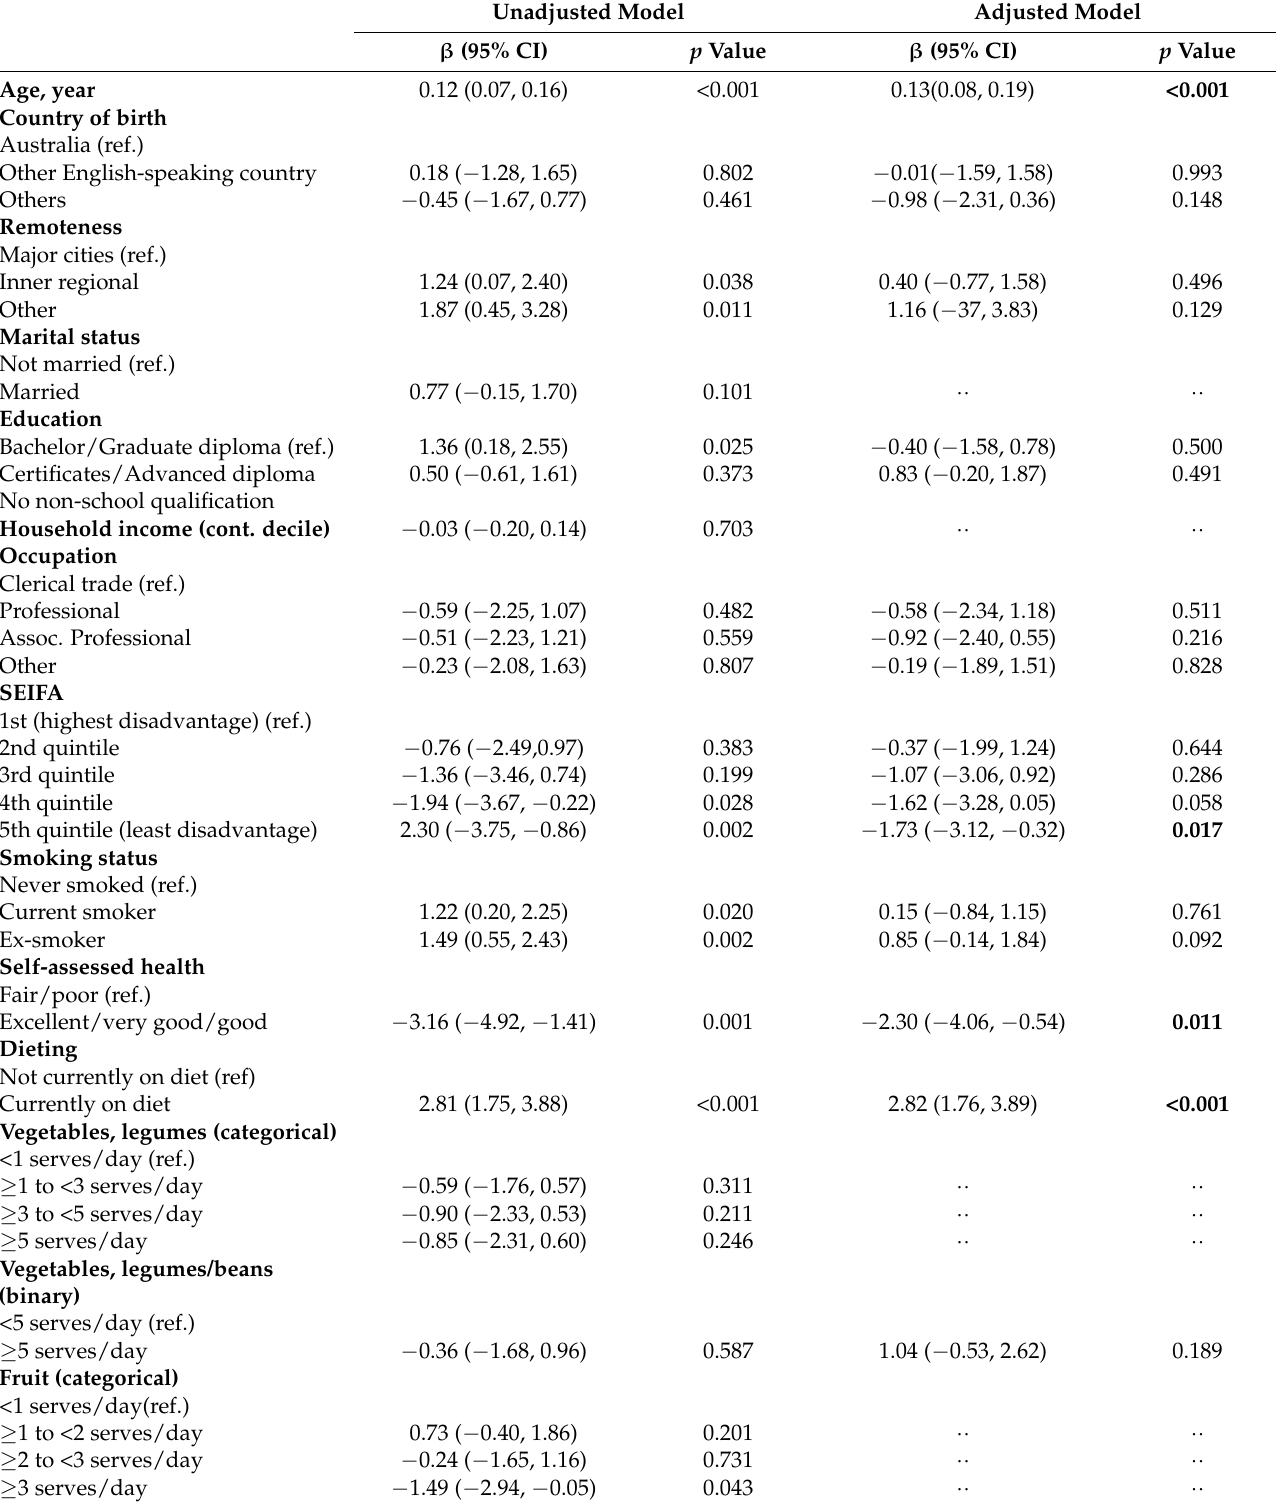
Table 5. Associations between diet and physical activity and BMI in postpartum women (N = 1292). Unadjusted Model Adjusted